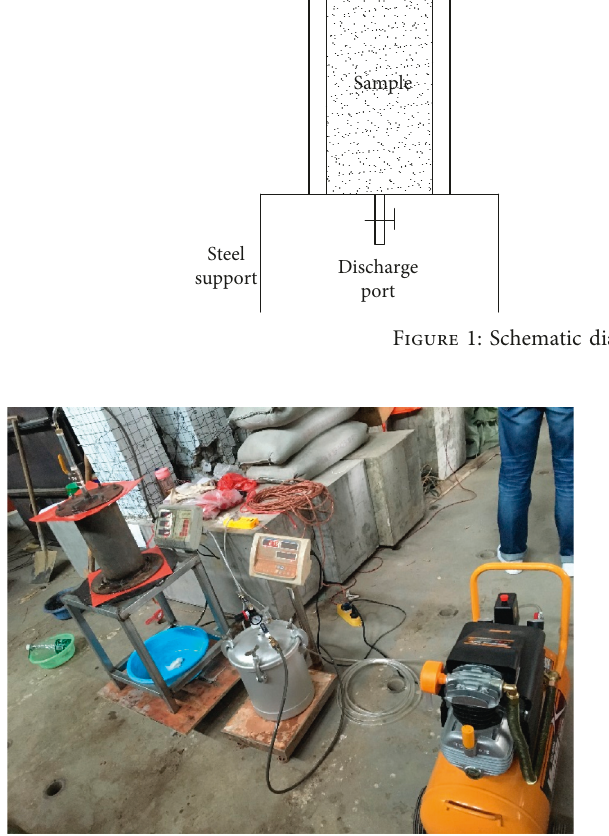
Figure 2: Test device real